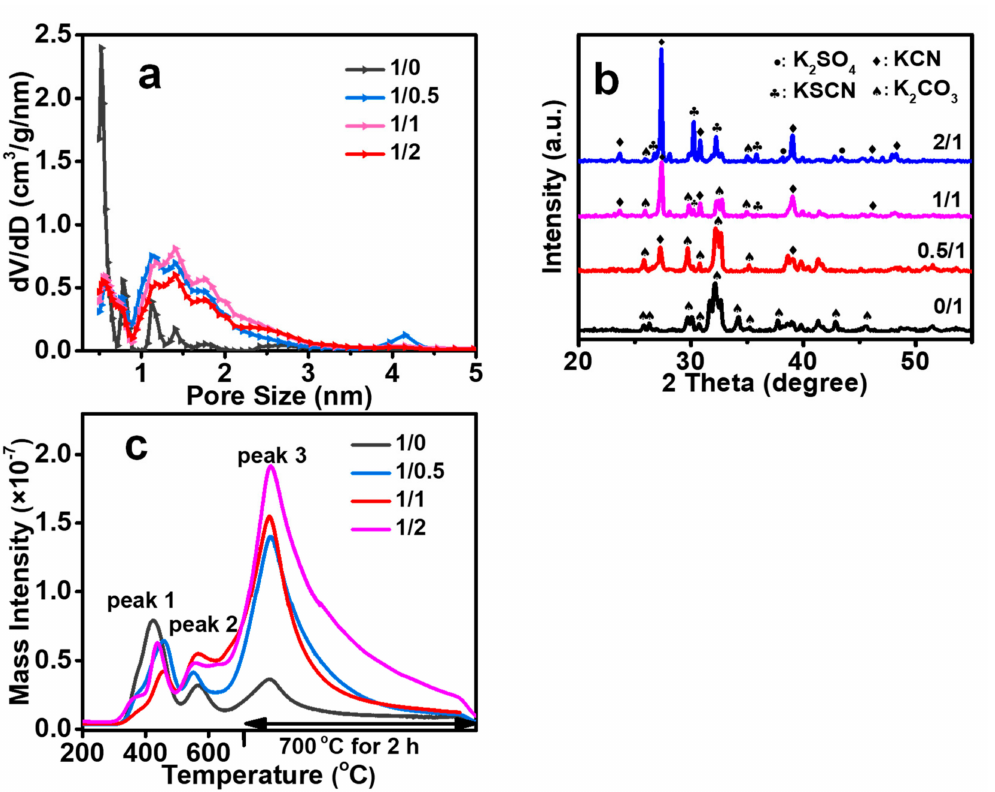
Figure 4. ( a ) Pore size in NSC materials, ( b ) XRD patterns of the unwashed NSC materials, ( c ) CO release curves of the NSC materials. The activation conditions were set to be 700 ◦ C, K 2 CO 3 : biomass mass ratio of = 1:1, various mass ratios between KSCN and